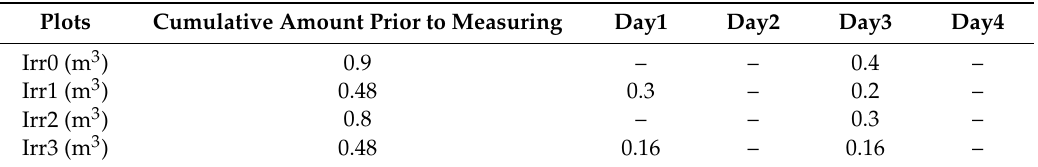
Table 1. Water regimes of 4 plots. Irrigation was conducted at night on Day1 (30 July) and Day3 (3 August). The cumulative amount prior to measuring represents the total irrigation amount at different growth stages before the field campaign.